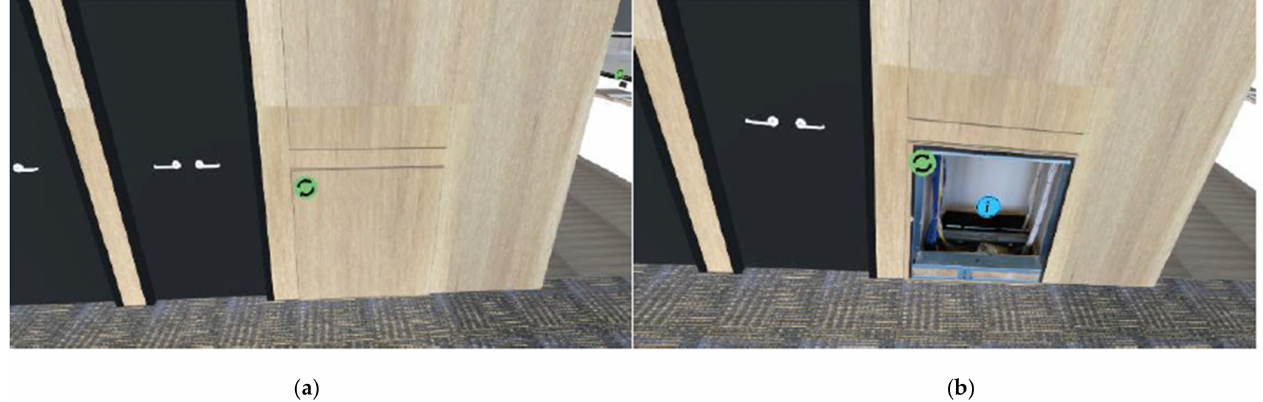
Figure 9. ( a ) Wall panelling hides the service duct connecting the roof space to the first floor and ground floor ceiling. ( b ) VR model exposes the lower access panel, revealing the service